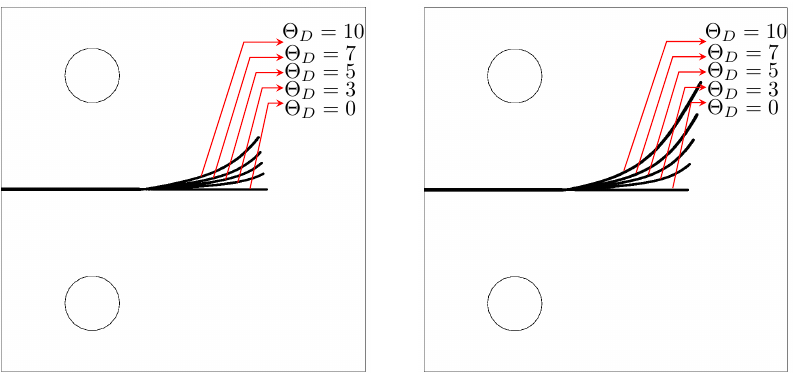
Figure 16. Comparison of the crack paths using TF-PFM1 ( left ) and TF-PFM2 ( right ) with the given temperature variations under Mode I at the final computational time t =